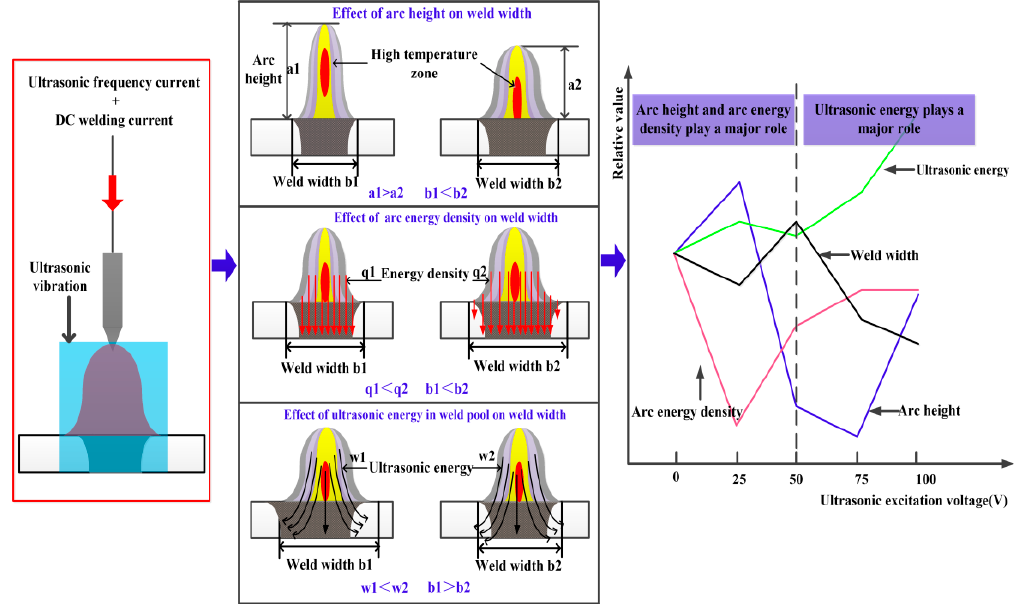
Figure 9. Diagram of influence of arc ultrasonic excitation voltage on weld width.